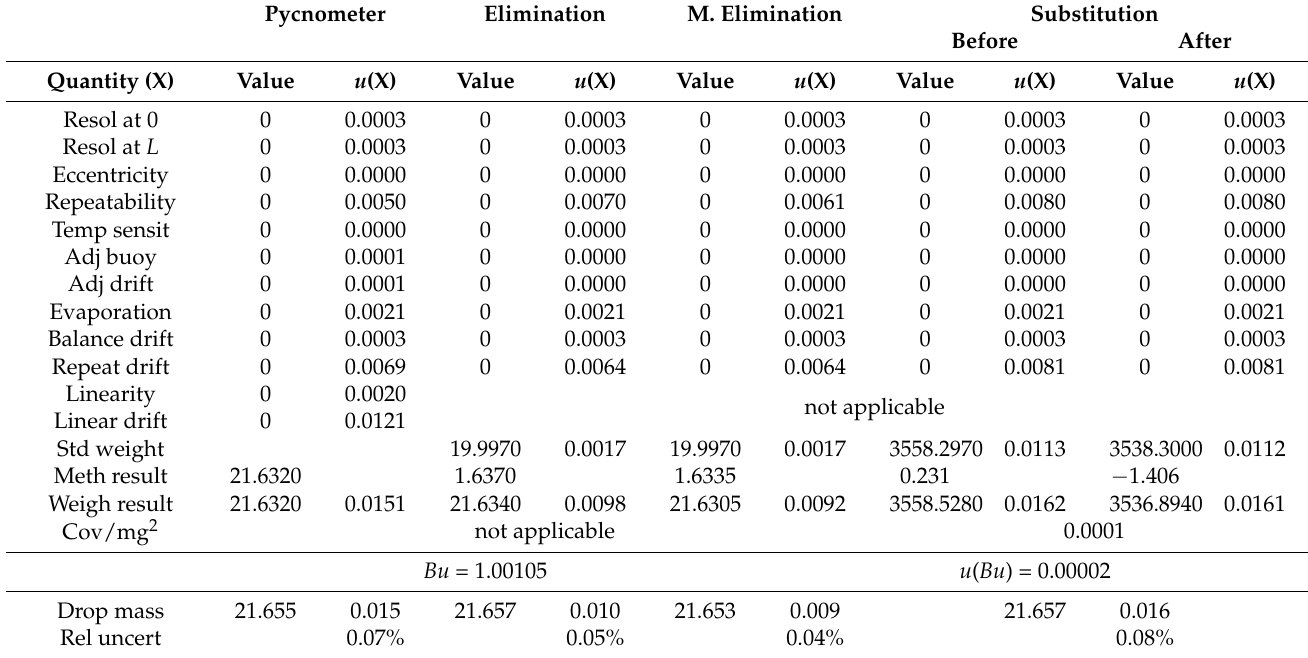
Table 4. Uncertainty budget *.